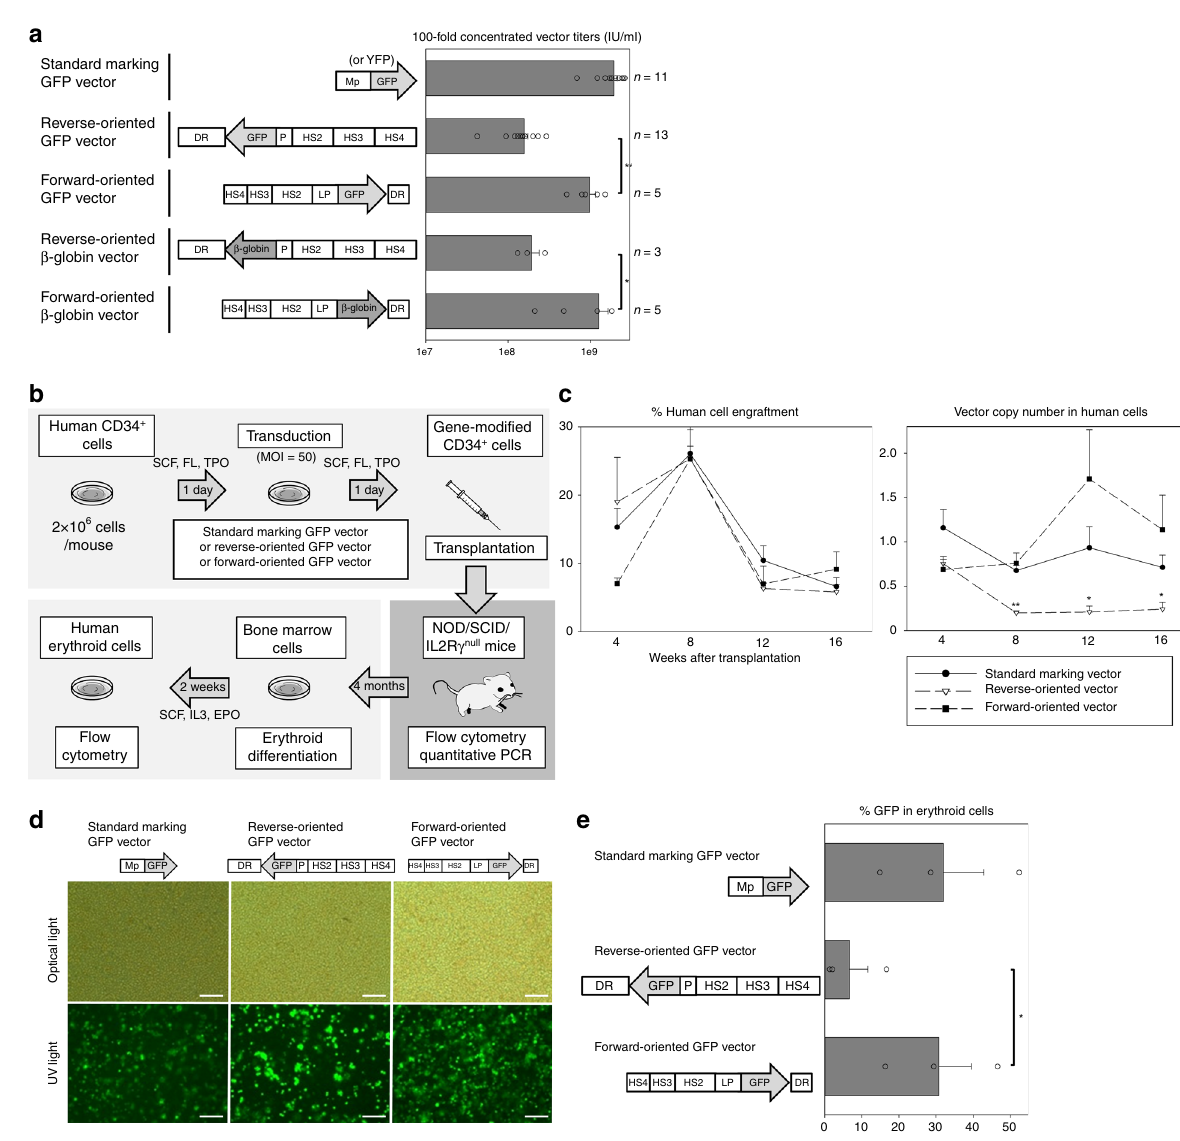
Fig. 1 Higher vector titers with 100-fold concentration and more ef fi cient transduction in xenograft mice for the optimized forward-oriented vector for globin expression. a We produced the forward-oriented globin-expressing vector with 100-fold concentration, which was optimized by the use of a short β -globin locus control region (LCR) composed of hypersensitive sites 2, 3, and 4 (HS2, HS3, and HS4), a large size of the β -globin promoter (LP), and a β -globin downstream region (DR) lacking the polyA signal. Vector titers of the forward-oriented vectors were evaluated, as compared with the optimized vector in the reverse orientation and a standard GFP-marking vector ( n = 3 – 13). ** p < 0.01, * p < 0.05 evaluated by t -test. b We transduced human CD34 + cells with reverse-oriented vector, forward-oriented vector, and standard marking vector with a GFP marker gene, and the transduced cells were transplanted into NOD/SCID/IL2R γ null mice ( n = 3 – 5). Four months after transplantation, xenograft bone marrow cells were collected and cultured for human erythroid cells with human speci fi c cytokines. c Human cell engraftment and average vector copy numbers (VCNs) in peripheral blood cells were evaluated for 4 months post transplant. ** p < 0.01 and * p < 0.05 evaluated by Dunnett ’ s test, compared with the forward-oriented vector. d , e After human erythroid cell differentiation from xenograft bone marrow cells ( n = 3), we evaluated GFP expression using fl uorescence microscopy ( d ) as well as GFP- positive percentages in erythroid cells by fl ow cytometry ( e ). Scale bars represent 100 μ m. * p < 0.05 evaluated by t -test between forward-oriented and reverse-oriented vectors. EPO: erythropoietin, FL: fms-related tyrosine kinase 3 ligand, GFP: enhanced green fl uorescent protein, IL3: interleukin 3, MOI: multiplicity of infection, Mp: murine stem cell virus promoter, P: β -globin promoter, PCR: polymerase chain reaction, SCF: stem cell factor, TPO: thrombopoietin, YFP: enhanced yellow fl uorescent human erythroid cells using human-speci fi c cytokines (Fig. 1b). forward-oriented vector performs at the level of our standard Two weeks after human erythroid cell differentiation, the constitutively active marking vector. forward-oriented vector demonstrated fourfold higher GFP- positive percentages (31 ± 9%, p < 0.05) as compared with the reverse-oriented vector (7 ± 5%), which was similar to the standard marking vector (32 ± 11%) (Fig. 1d, e and Supple- mentary Fig. 5A), demonstrating for the fi rst time that this